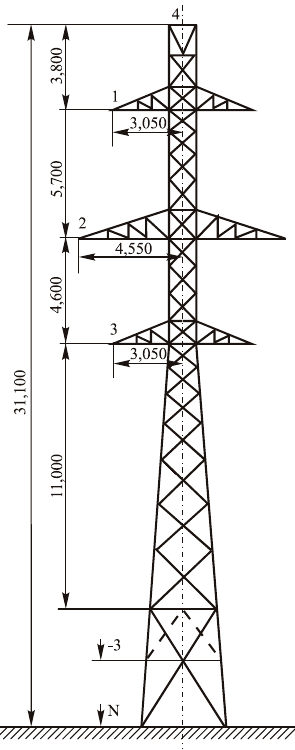
Figure 3. Type of tower used to construct the analyzed line.